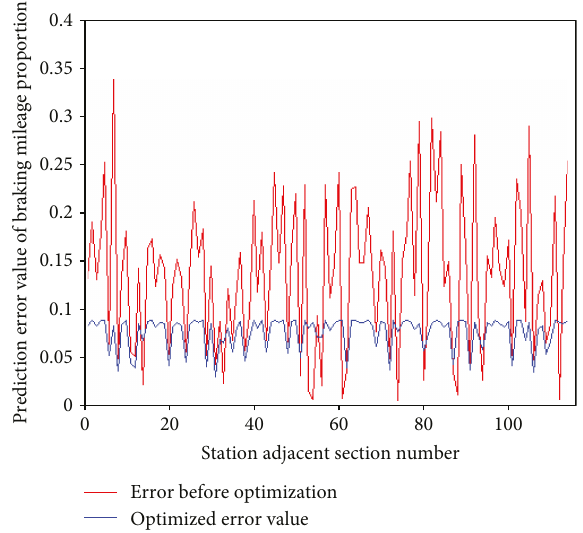
Figure 10: In fl uencing factors prediction error of RBF neural network before and after optimization (total